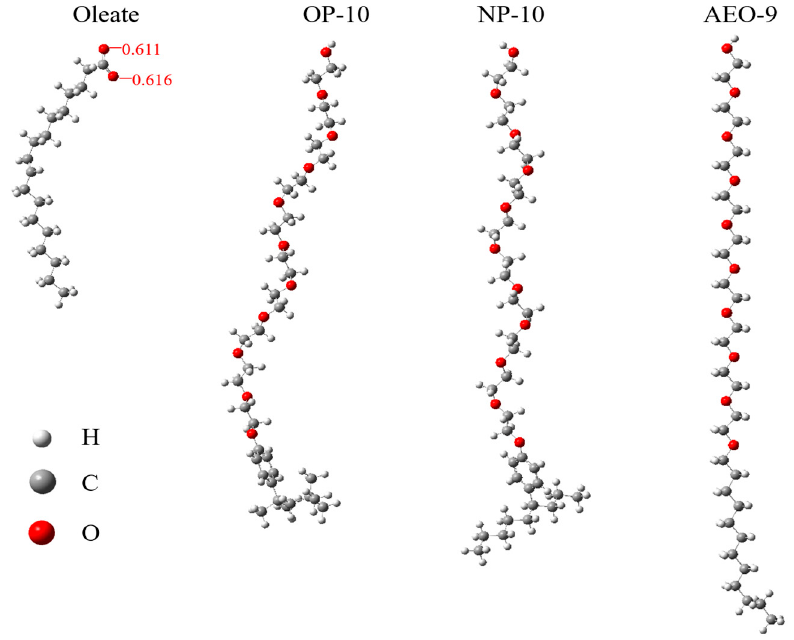
Figure 6. Optimized geometry structure of oleate, OP ‐ 10, NP ‐ 10 and AEO ‐ 9 by DFT.